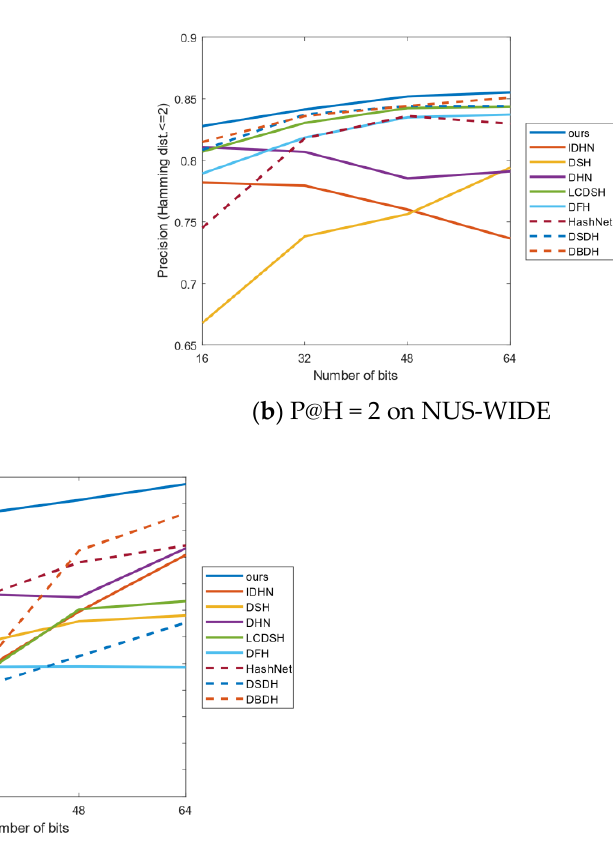
Figure 5. ( a – d ) represent the PR curves on Imagenet-100 of all algorithms when the length of the hash code is 16, 32, 48 and 64 bits, respectively.